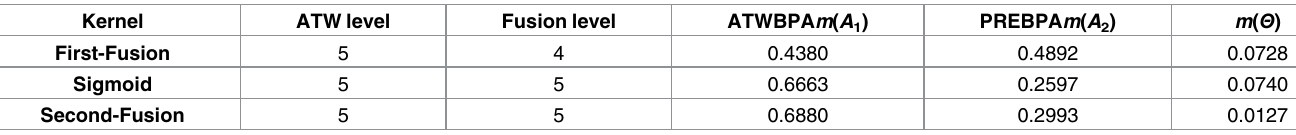
Table 8. The fusion results of the second step.